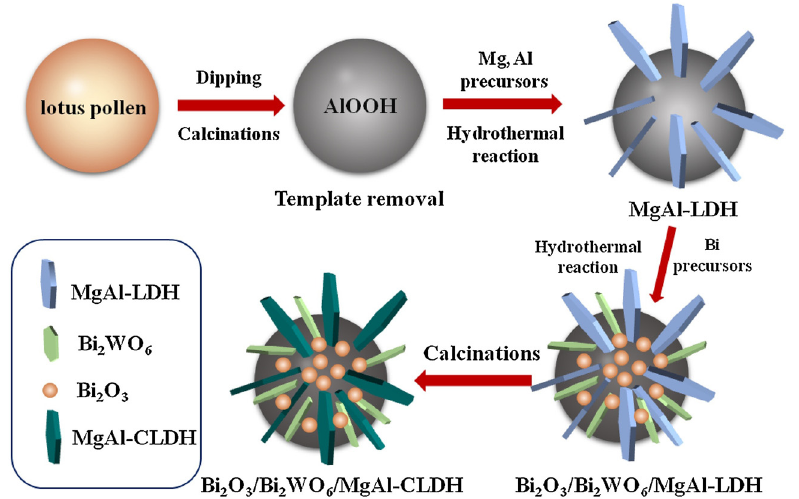
Figure 5: The synthesis process of Bi 2 O 3 /Bi 2 WO 6 /MgAl - CLDH. Reproduced with permission from ref. [ 96 ] ; copyright ( 2018 ) , Elsevier.